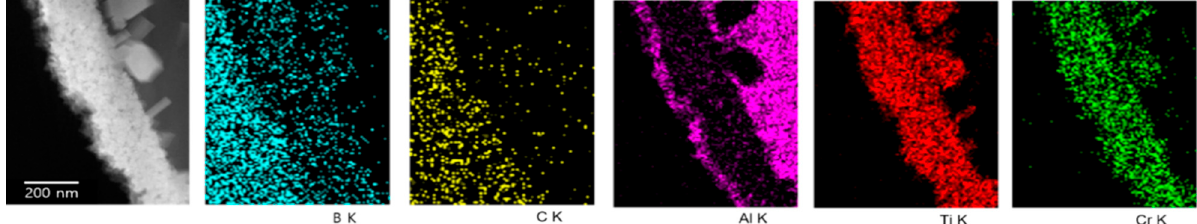
Figure 5. Transmission electron microscope (TEM)—energy dispersive spectroscopy (EDS) mapping images of B 4 C/Al6061 composites fabricated by stir casting, indicating the presence of an interfacial layer.